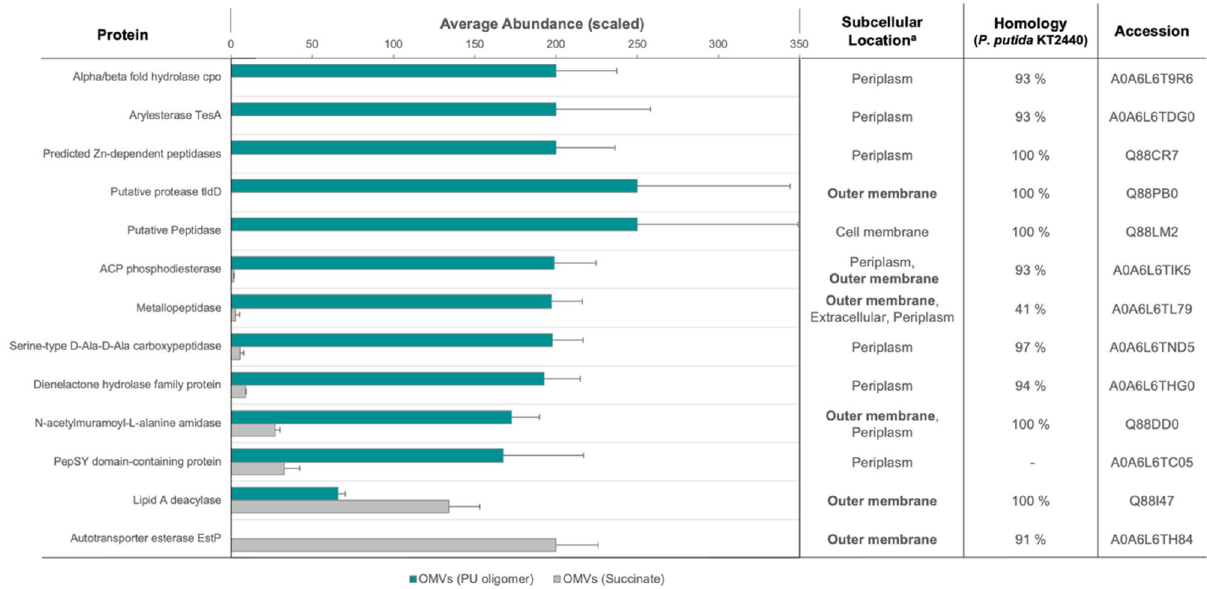
Figure 5. Candidate list from mass spectrometry of OMV samples in both PU oligomer and succinate. Candidates were selected due to their abundance in the OMV samples, their subcellular location, and their homology to proteins in P. putida KT22440. a In the case that subcellular location was not annotated for the respective protein, prediction via CELLO v.2.5. The proteomes of OMVs from cells grown on succinate and OMVs from cells on the PU oligomer clearly differ from each other and esterases were detected in both